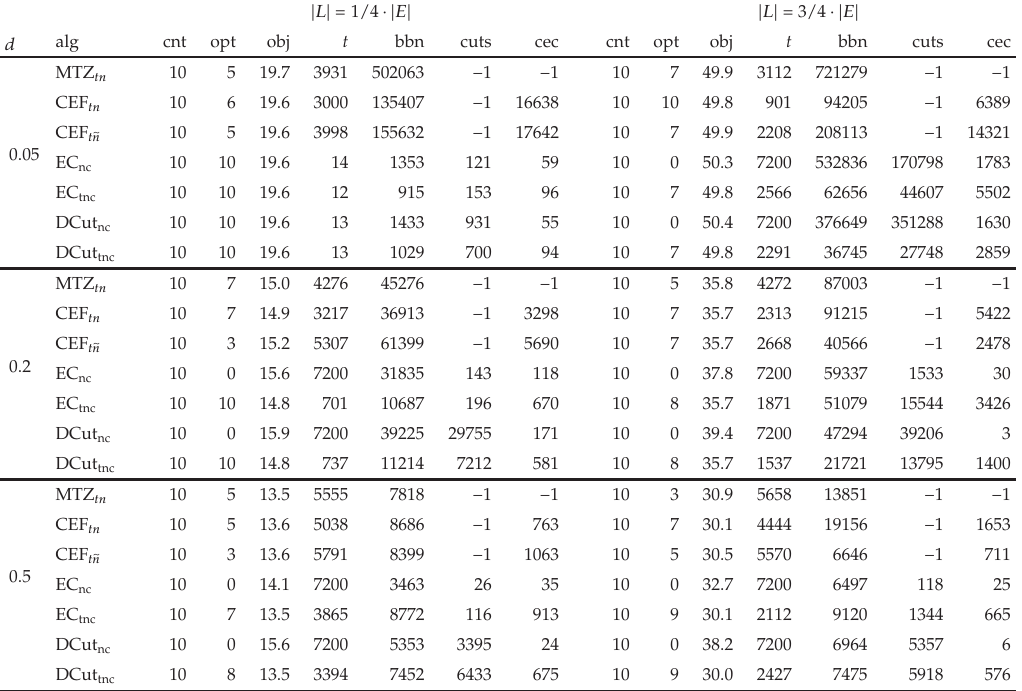
Table 9: Comparison of various formulations based on cycle elimination, that is, the Miller-Tucker-Zemlin formulation MTZ and the CEF on the instances from SET-III with | V | (cid:6) 100 , a (cid:6) 1. Furthermore results for connectivity-based formulations (cid:2) EC and DCut (cid:3) , enhanced by cycle elimination inequalities are